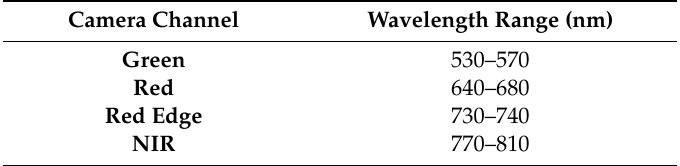
Table 2. Spectral sensitivities for the Parrot Sequoia’s four spectral bands.